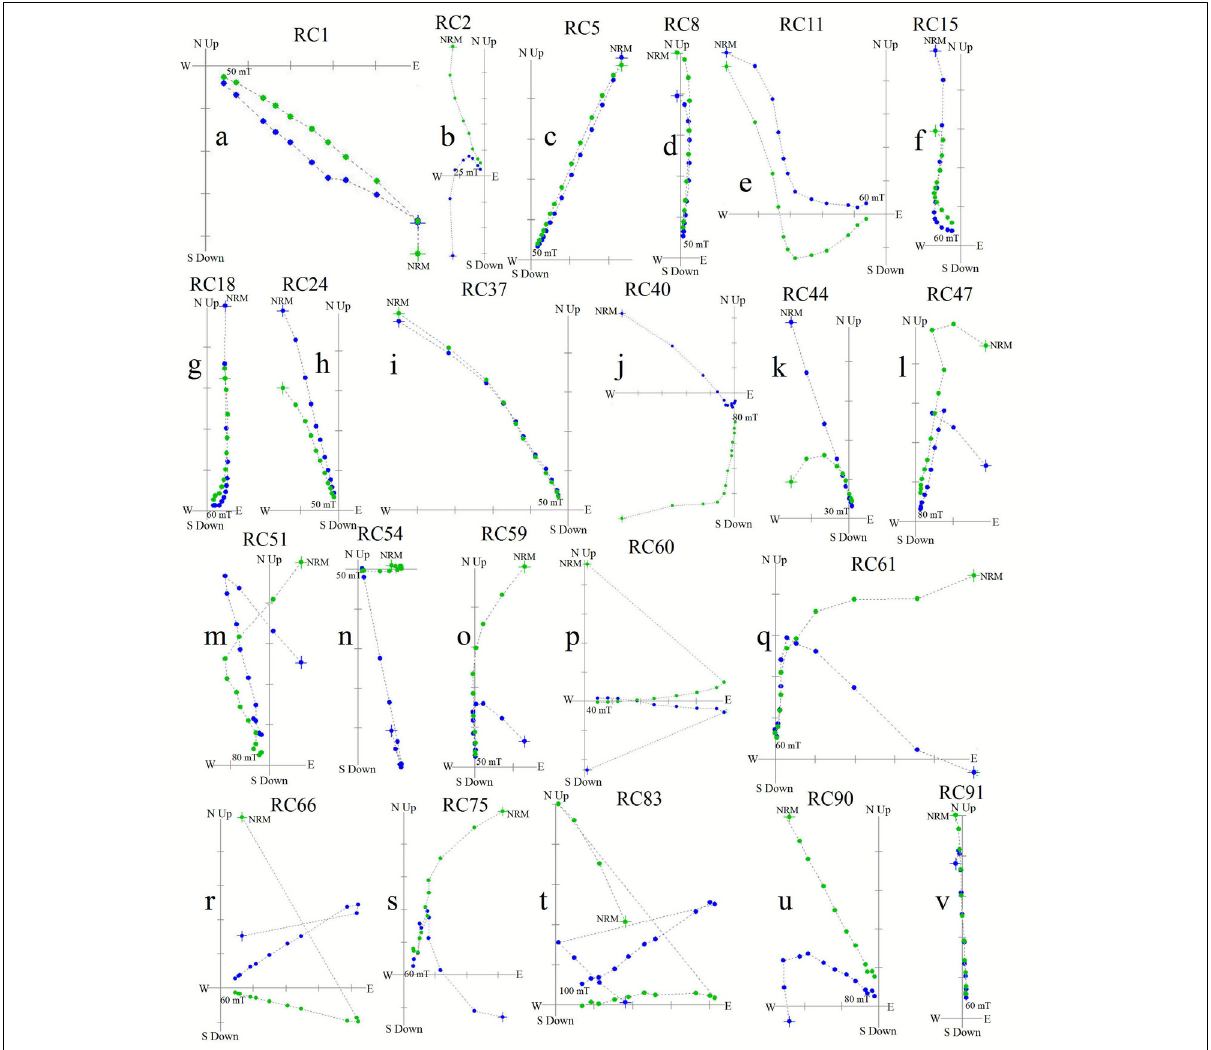
Figure 4: Vector components diagrams showing the behaviour of typical samples cleaned using alternating field progressive demagnetisation from Rose Cottage Cave. The totality of the vector projection diagrams illustrated in the figures is directional data with corrected field. Blue and green symbols correspond to projection on the horizontal and vertical planes, positive inclination values. Figure 5 illustrates the stereographic projection of characteristic remanent magnetisation for the RC sampling.